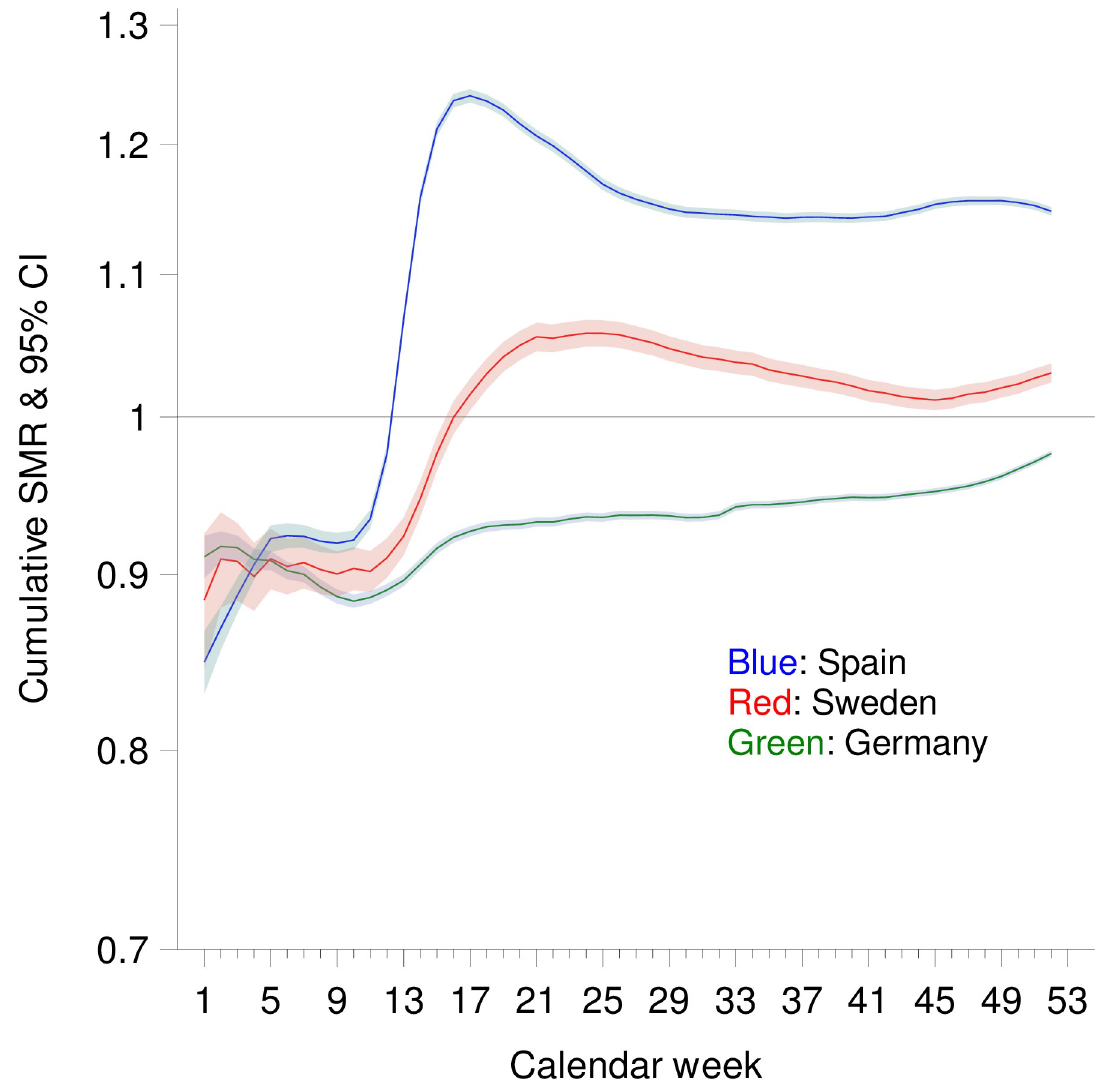
Fig 2. Cumulative standardized mortality ratio (SMR) by calendar week in Spain, Germany and Sweden (no consideration of life expectancy).